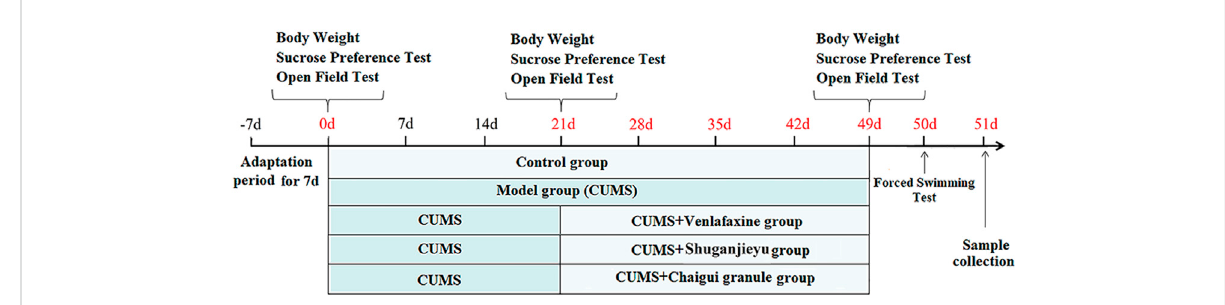
FIGURE 1 Schematic diagram of CUMS, drug treatment, and behavioral testing program schedule. Behavioral tests include sucrose preference test, open fi eld test, and forced swim test.